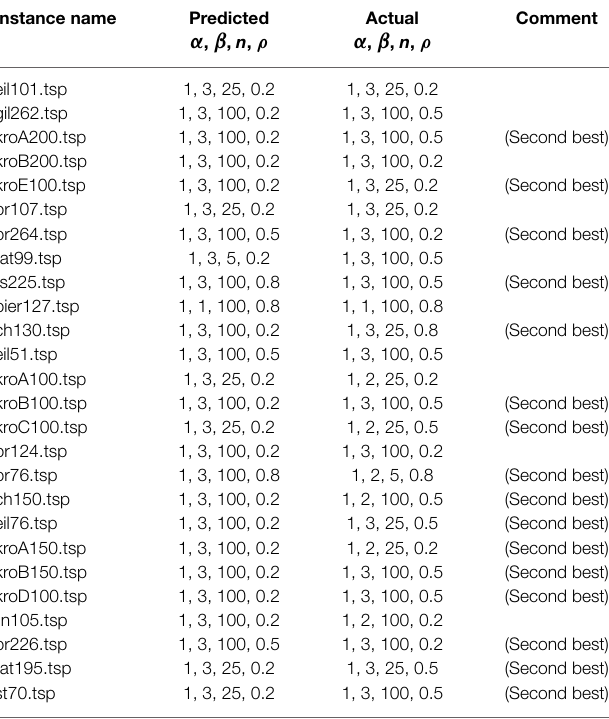
Note that the underlying model is based only on our analysis of instances of size 100.